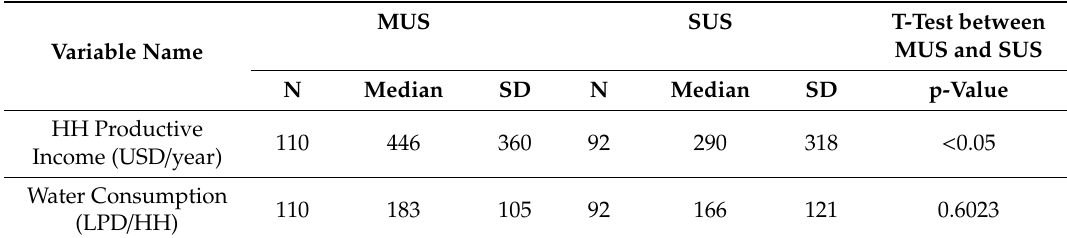
Table 5. Descriptive statistics for MUS and